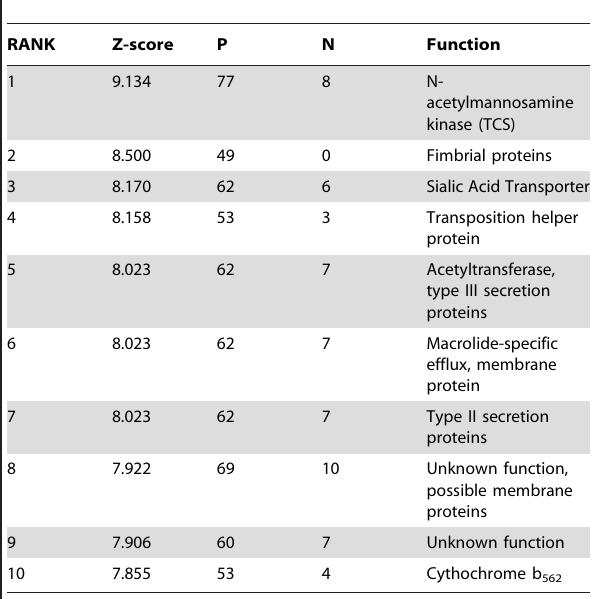
Table 4. Top 10 ranking non-pathogenic protein families and annotated functions of their proteins for TM- Gammaproteobacteria